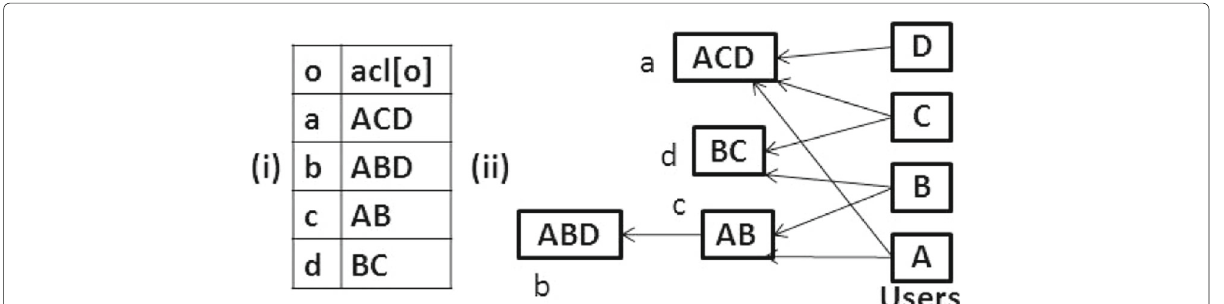
Fig. 8 ( i ) Example ACL s with read authorization, and ( ii ) A minimal vertex user